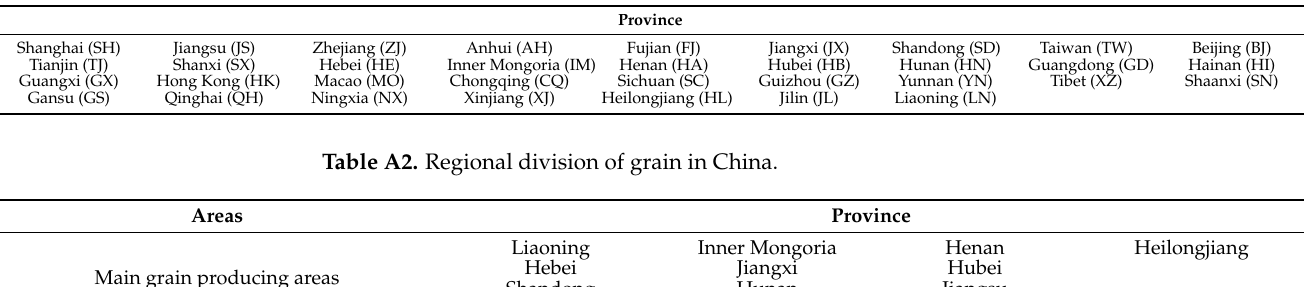
Table A1. Chinese provincial names and corresponding abbreviations.